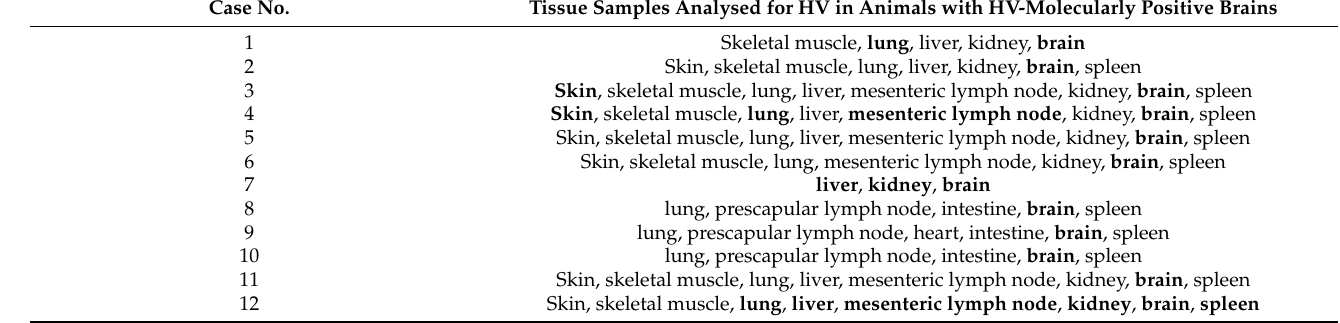
Table 3. Tissue samples tested for HV in the twelve animals with HV-molecularly brain samples from our study. Positive samples are indicated in boldface.